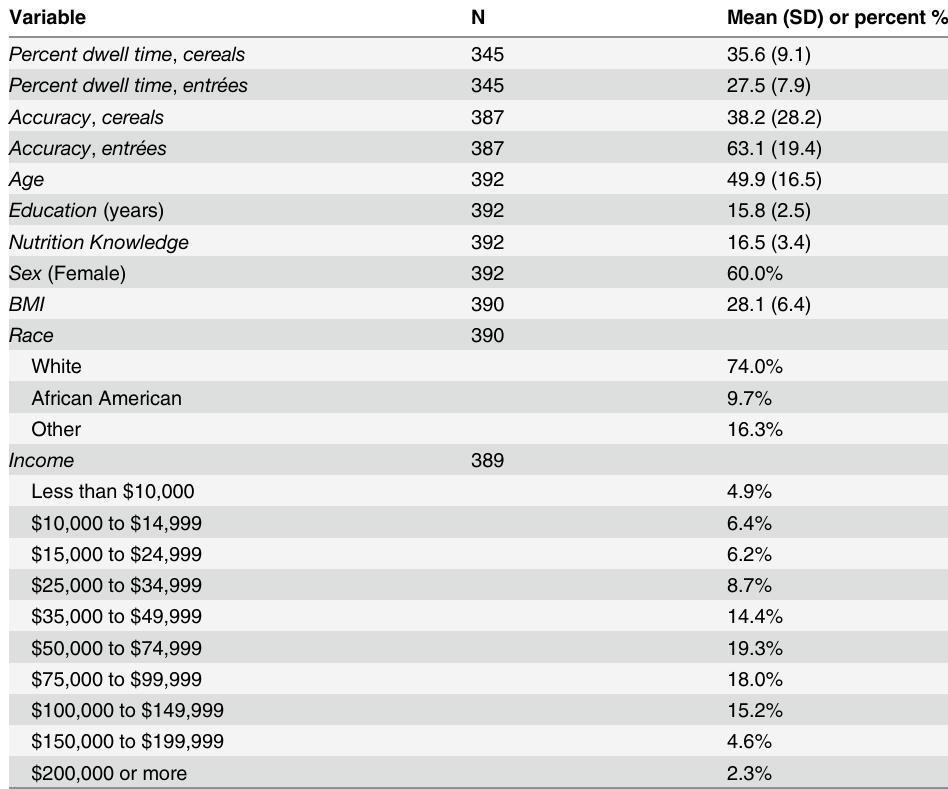
Table 1. Characteristics of Study